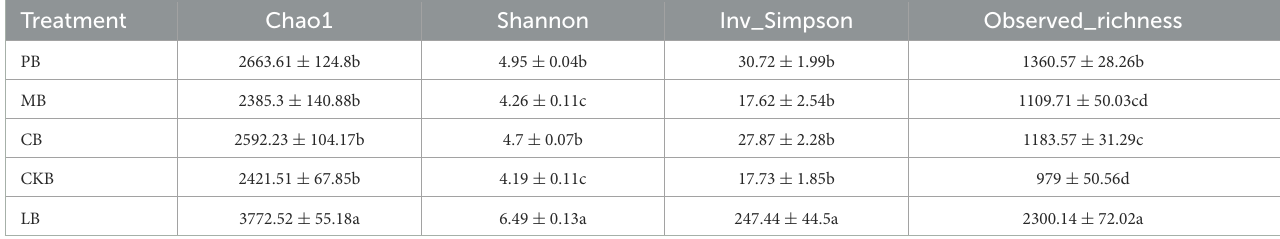
TABLE 1 Summary of α diversity indices among different treatments.